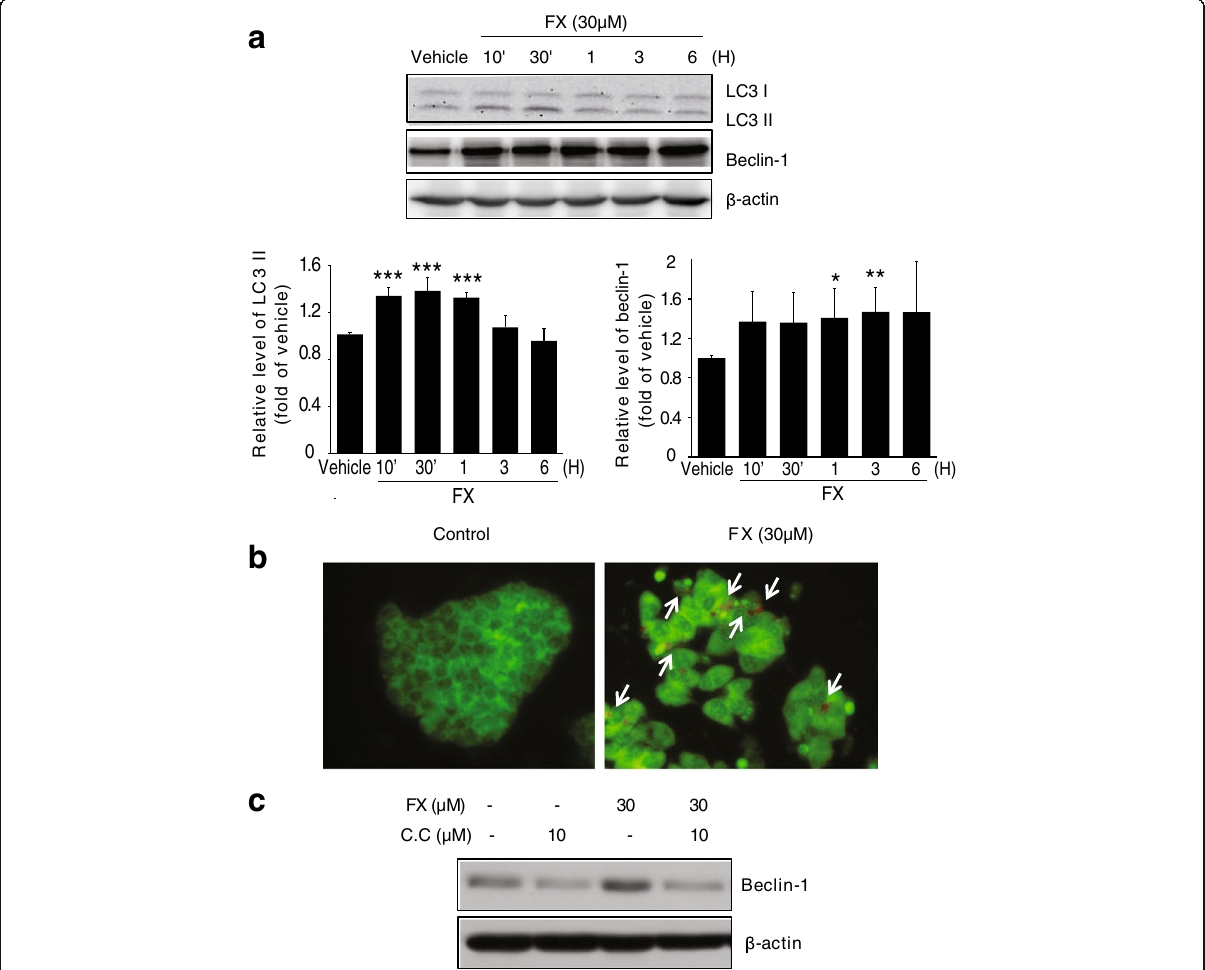
Fig. 4 The effect of FX on autophagy induction in HepG2 cells. ( a ) FX induces time-dependent activation of the autophagy related proteins, LC3II and Becline-1. Western blot analyses were performed on the lysates of cells that had been treated with 30 μ M FX for the indicated time period. β -actin served as a loading control. Protein levels were presented as relative band intensities to control (vehicle treated) group. Results represent the mean±S.D. for four separate experiments. ** p <0.01; *** p <0.001. ( b ) The pictures of the fluorescence micrographs show the formation of AVOs resulting from the treatment of FX in HepG2 cells. Cells were incubated either in the presence or absence of 30 μ M FX for 6 h and were stained with AO. The presence of AVOs was indicated by the red fluorescence. ( c ) Inhibition of FX-induced autophagy by C.C. Western blot analysis of Beclin-1 were performed with lysates of HepG2 cells that had been pretreated with 10 μ M C.C for 1 h being followed by exposure to 30 μ M FX for 1